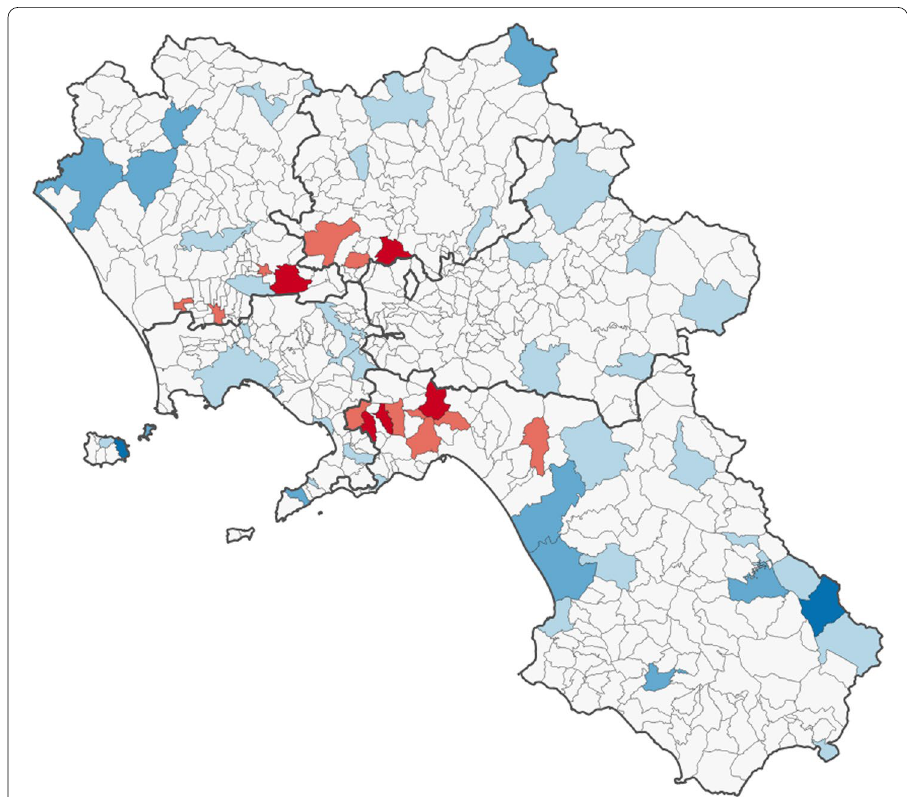
Fig. 10 Model 2: Random effects for each municipality. If more schools belong to same municipality, the average effect is computed. Blue color: positive effects; red color, negative effects; white color, not significant